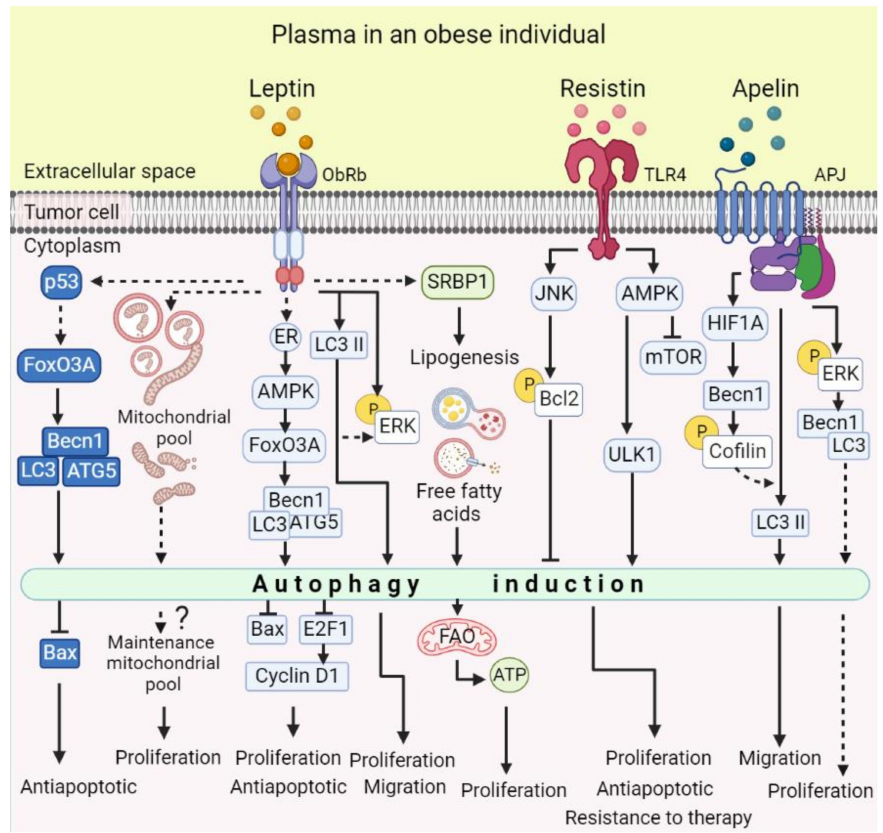
Figure 4. Molecular mechanisms of the effect of adipokines on autophagy and tumor cell malignancy. Different mechanisms involved in the induction of autophagy by leptin have been described. Leptin- induced autophagy has been shown to regulate proteins involved in proliferation and apoptosis, such as cyclin D1 and Bax. The autophagy-mediated regulation of Bax involves the p53/FoxO3A axis, which transcriptionally regulates autophagy-related proteins. Specifically, in ER-positive breast cancer cells, leptin-induced autophagy is ER-dependent, involves AMPK activation, and regulates Bax and Cyclin D1 levels. Leptin-induced autophagy is implicated in cellular migration through the regulation of ERK phosphorylation. Additionally, leptin-induced autophagy could be a mechanism for maintaining the mitochondrial pool, which would influence energetic metabolism. In this sense, leptin-induced autophagy is involved in the degradation of intracellular fat droplets, which provide free fatty acids that are oxidized and improve cancer cell metabolism. The first evidence for the role of resistin in autophagy demonstrated that resistin induces autophagy by decreasing the phospho- rylation of mTOR and ULK1, and upregulating p-AMPK. Another important signaling molecule involved in resistin-induced autophagy was JNK kinase, which mediated the phosphorylation of Bcl-2. Bcl-2 phosphorylation is known to lead to its dissociation from Beclin1, a required step in the autophagy process. On the other hand, apelin/APJ increases autophagy and promotes Becn1 expression via HIF1A. Interestingly, Beclin 1 regulates cofilin phosphorylation, which was important for apelin/autophagy-induced migration in lung adenocarcinoma. Additionally, it has been demon- strated that apelin-induced Becn1 and LC3 protein levels are dependent on the phosphorylation of ERK. This suggests an essential role for ERK in regulating apelin-induced autophagy proteins. Solid line: demonstrated mechanism; dashed lines: unknown